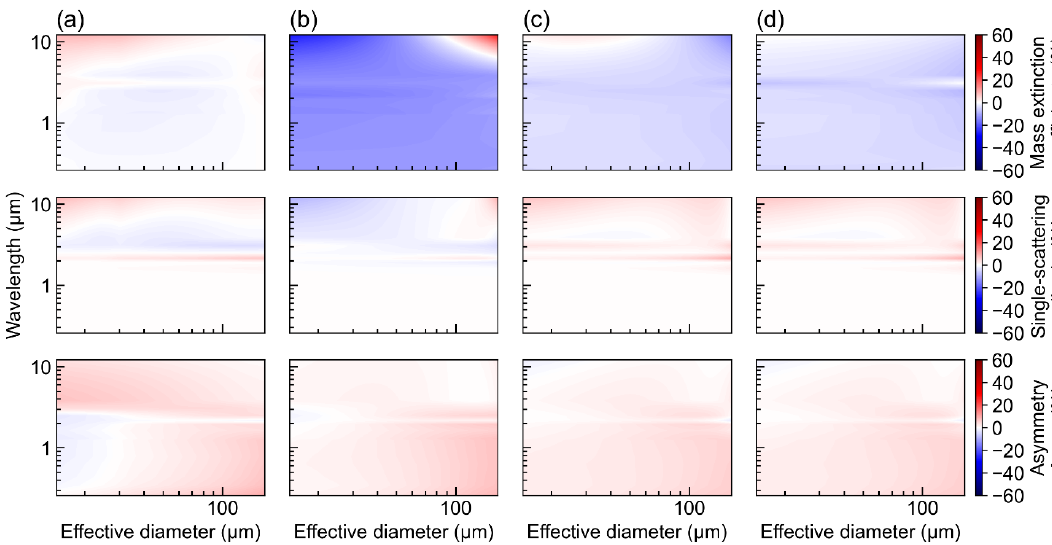
Figure 5. The (a) Mitchell, (b) Fu, (c) Baum-yang05 and (d) Yi schemes minus the Voronoi scheme differences (%) in (top row) mass extinction coefficients, (middle row) single-scattering albedo and (bottom row) asymmetry factor as functions of effective diameter and